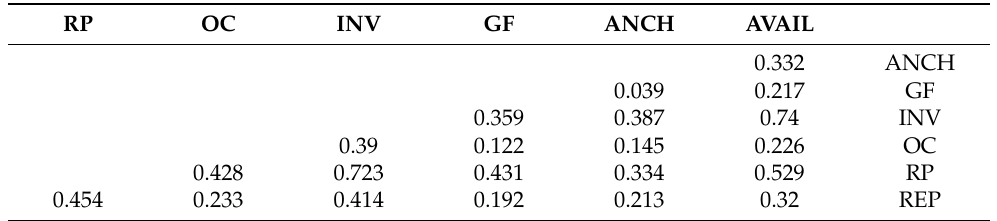
Table 4. HTMT ratio.